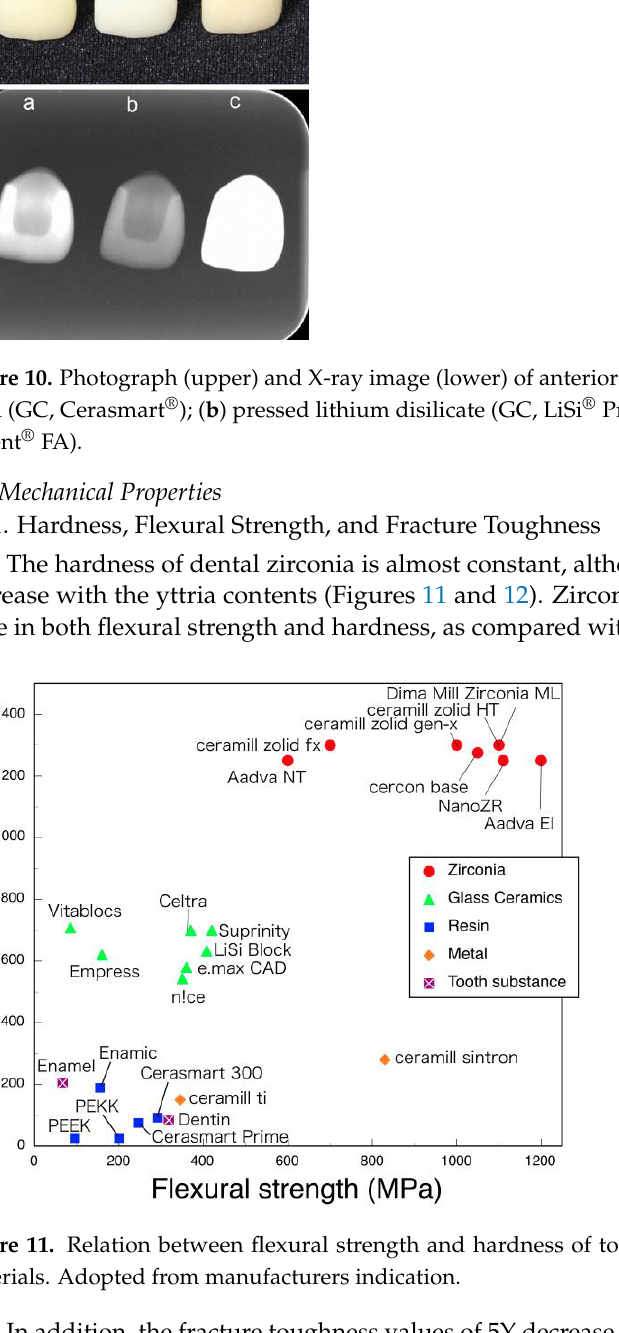
Figure 12. Flexural strength of tooth substance and CAD/CAM materials. Adopted from manufac- turers indication.